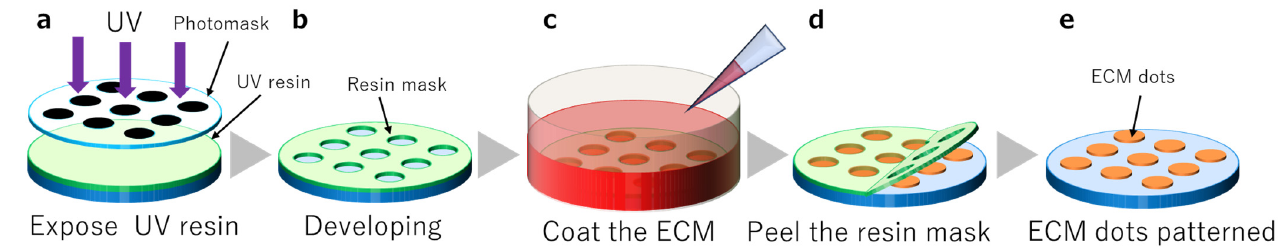
Figure 1. Resin mask fabrication and extracellular matrix (ECM) coating. ( a ): UV resin exposure, ( b ): Dot pattern development, ( c ): ECM coating, ( d ): Resin mask peeling, ( e ): Completion of ECM dots.